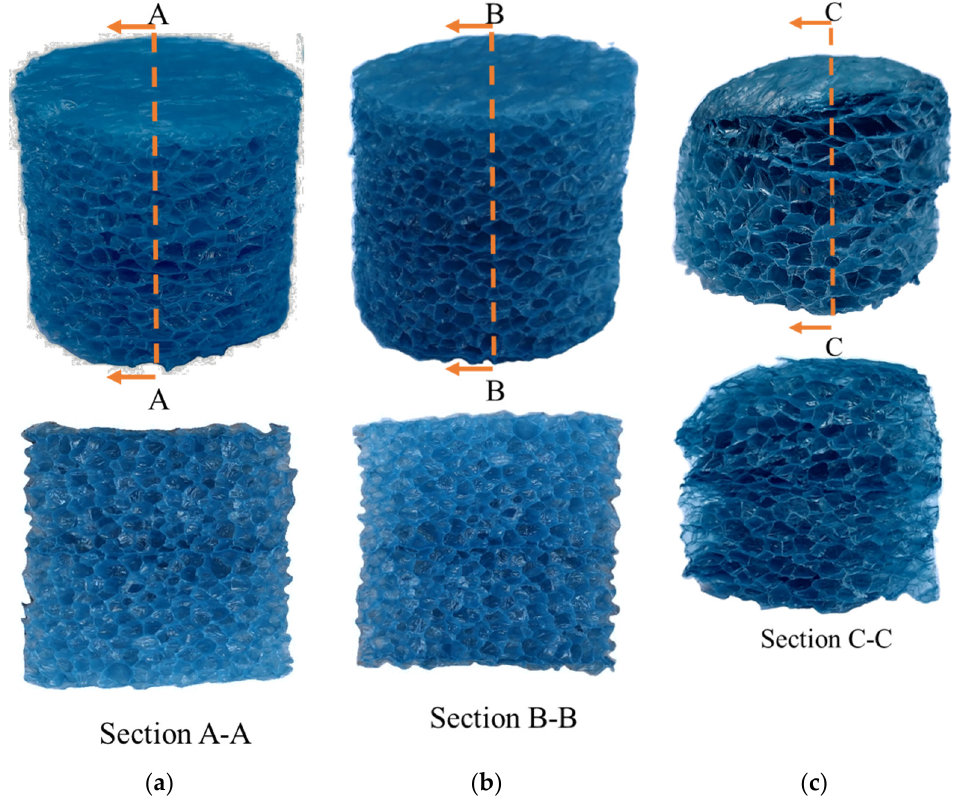
Figure 9. The final deformation of the foam under different loading rates, the bottom figures are the cross section of the specimens cut along the section marked in the top figures: ( a ) specimen failed under the quasi-static loading; ( b ) specimen failed under intermediate strain rate loading; ( c ) specimens failed under high strain rate loading.